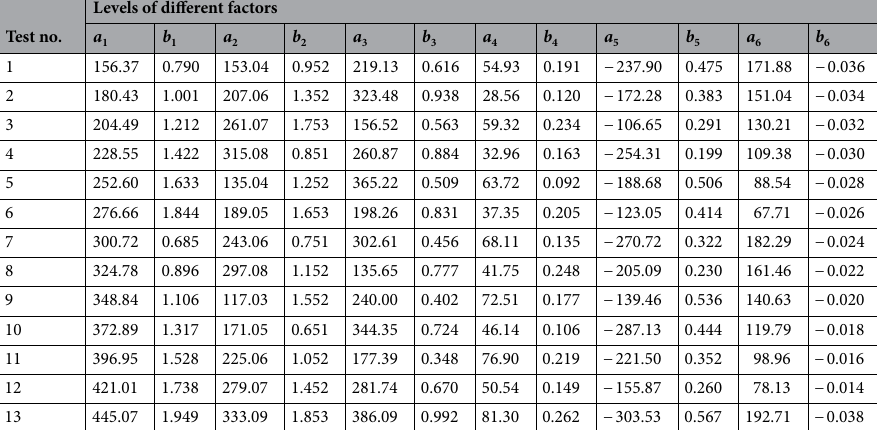
Table 5. U 13 uniform table of levels combination of different factors in each test.